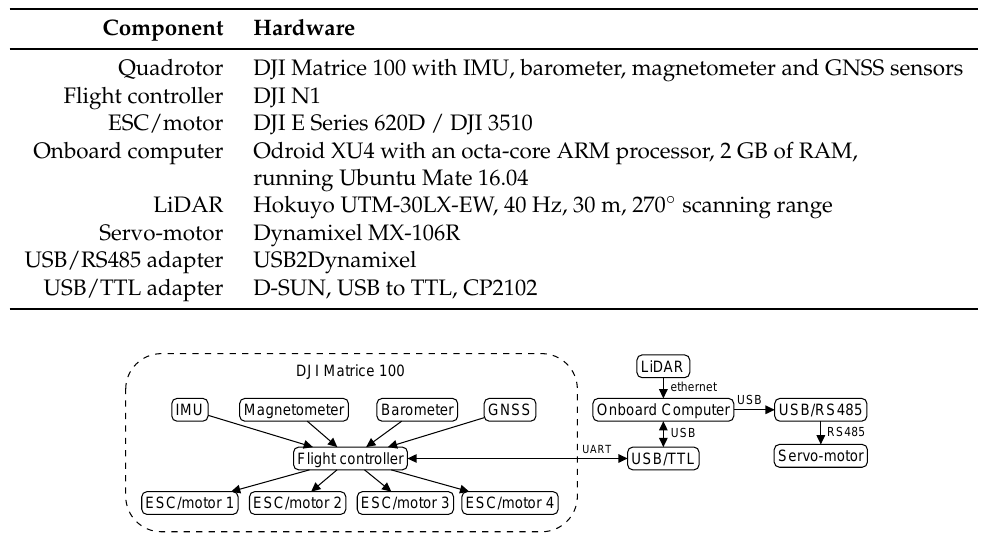
Table 1. MAV components.